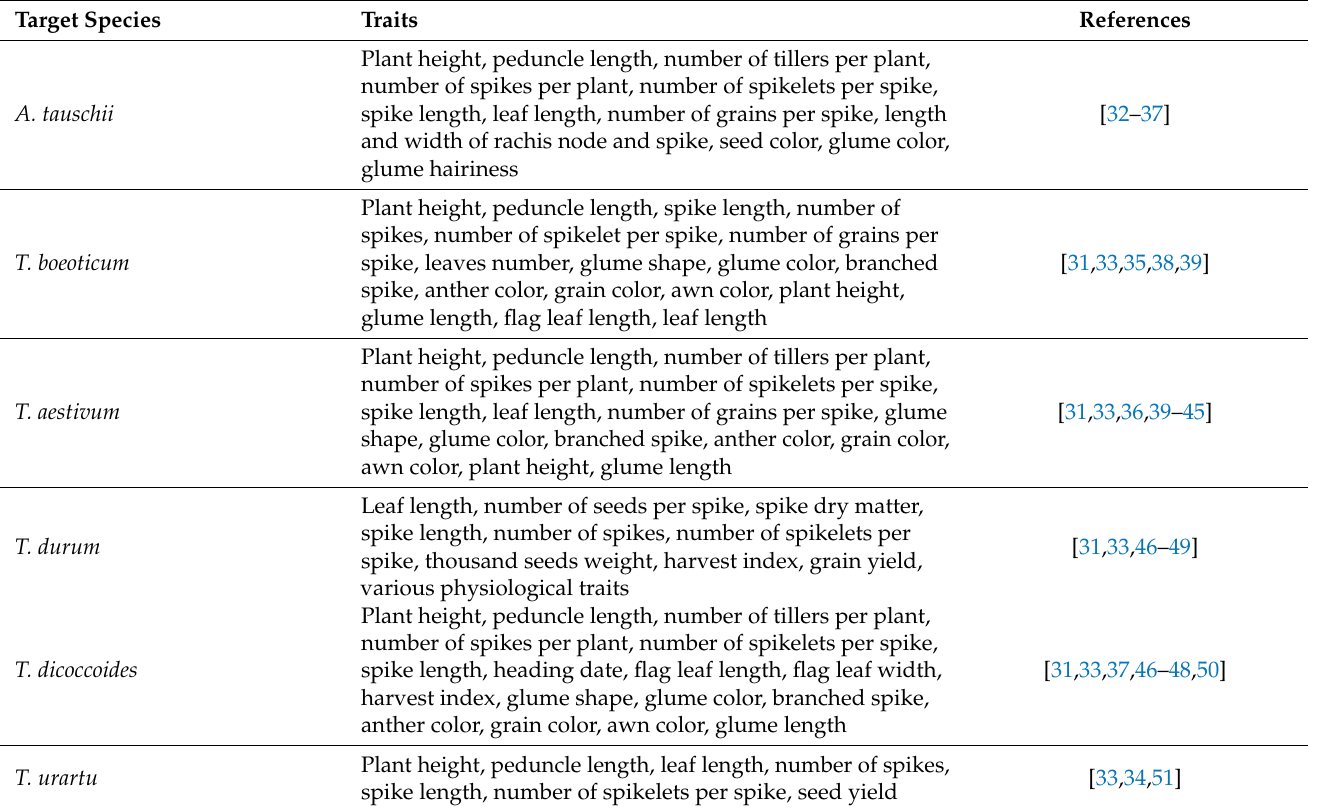
Table 3. List of several studies that reveal high levels of phenotypic diversity in wild relatives of wheat. Target Species